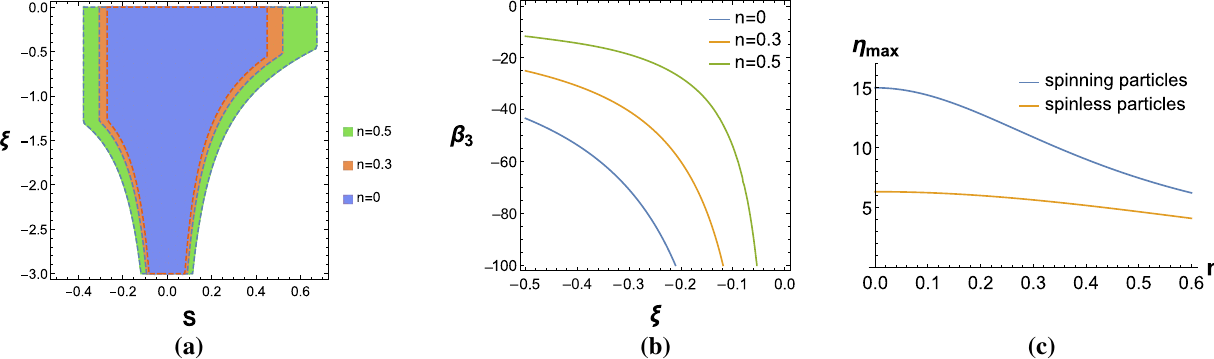
Fig. 4 a Theadmissibleregionofthe ξ andspin s withdifferentvaluesofNUTcharge n when E 2 = 1. b Therelationbetween ξ and β 3 fordifferent values of n when E 2 = 1. c The relation between maximum efficiency η max = E 3 max / 2 and NUT charge n for the spinning and non-spinning